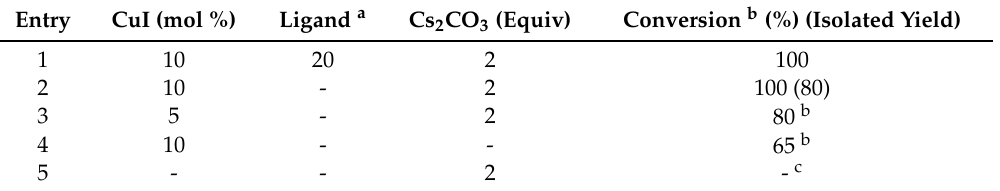
Table 3. Experimental condition optimization for the intramolecular metal-catalyzed cyclization of 12 .